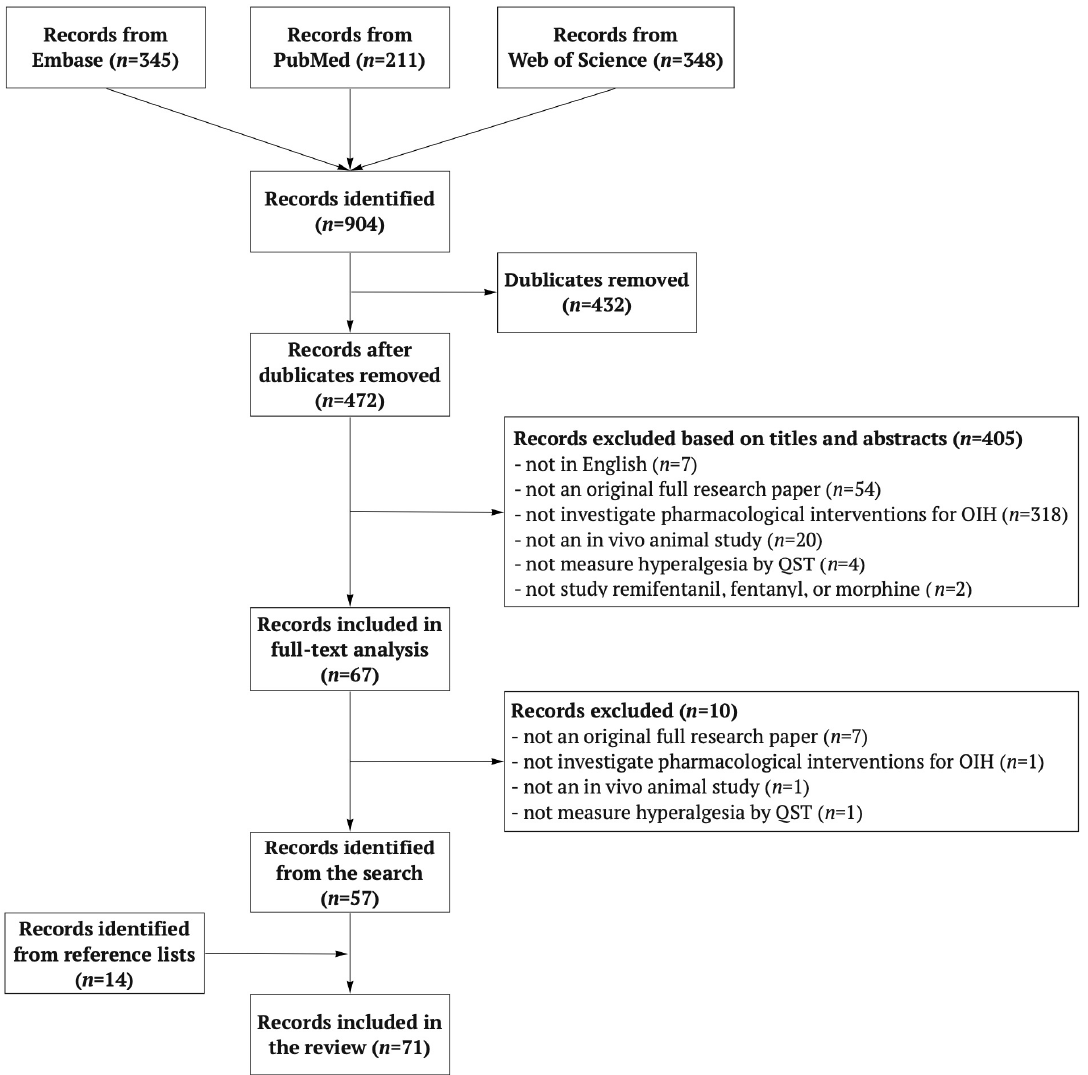
Figure 1. The process to identify eligible articles, in which 472 records were screened and 71 articles were included in the review.